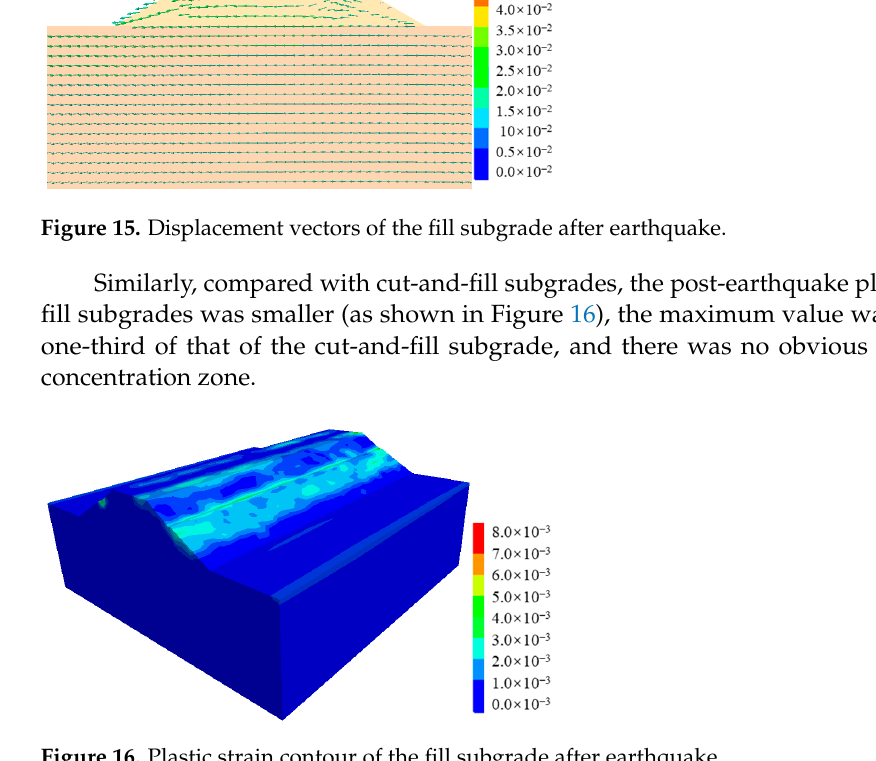
Figure 14. Displacement contour of the fill subgrade after earthquake.